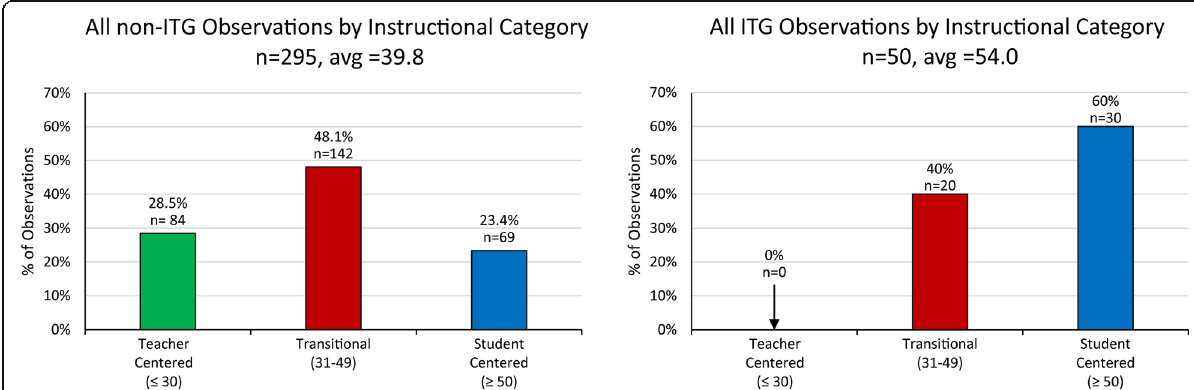
Fig. 5 Distribution of RTOP scores for all non-ITG and all ITG observations reported here. instructional categories are student-centered ( ≥ 50) or transitional (31 – 49) and teacher-centered ( ≤ 30), from Budd et al.,